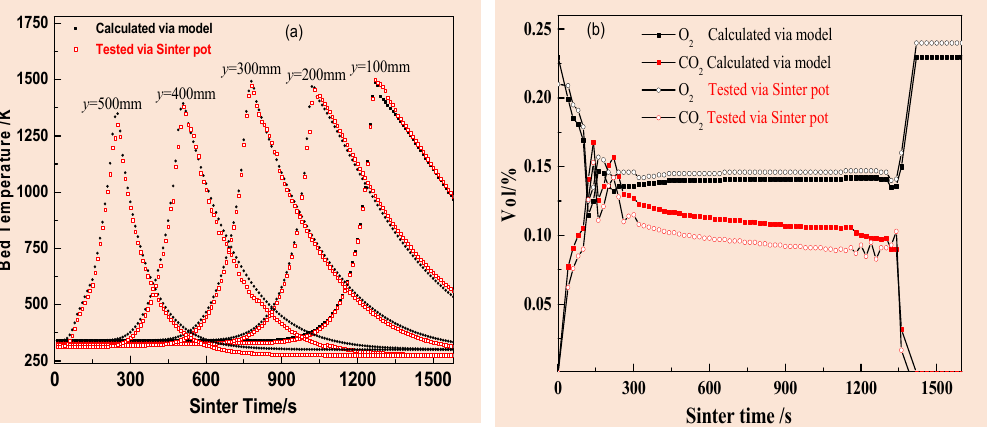
Figure 8. Results obtained from the model calculation and experimental tests. ( a ) temperature evolution at different bed heights; ( b ) exhaust gas composition.